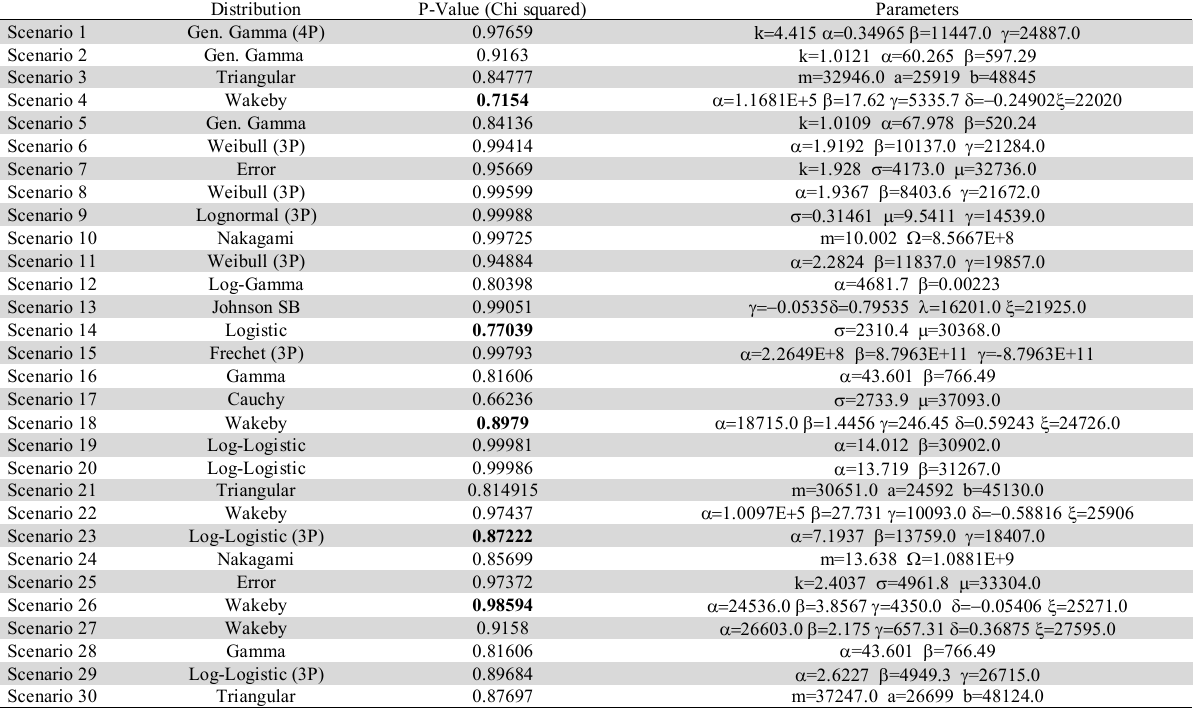
Distribution for scenarios total costs